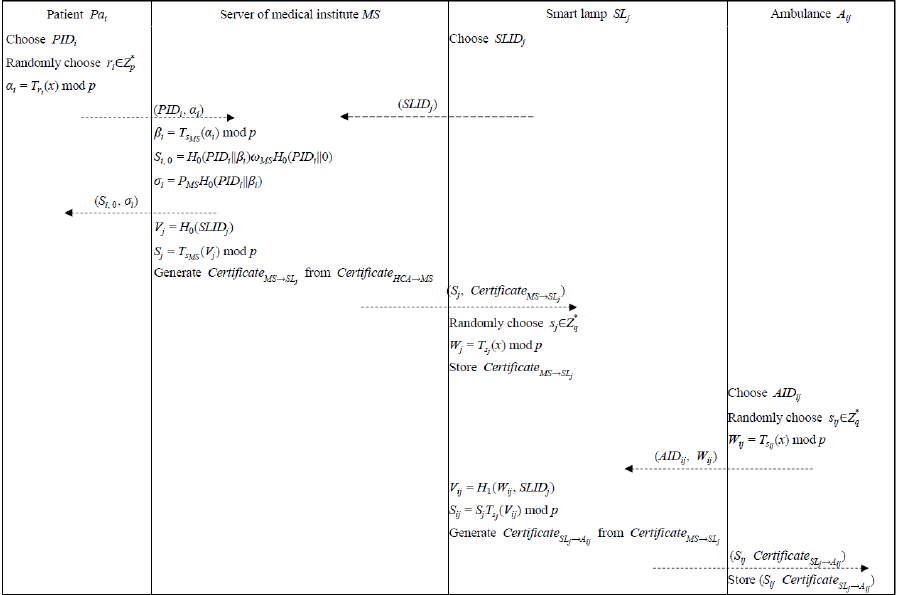
Figure 3. Registration phase.